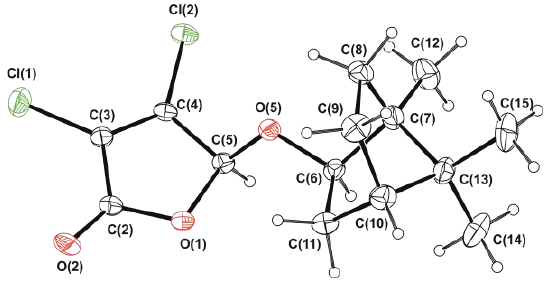
Figure 2. Molecular structure of 5-bornyloxy-2(5 H )-furanone 5а in the crystal.